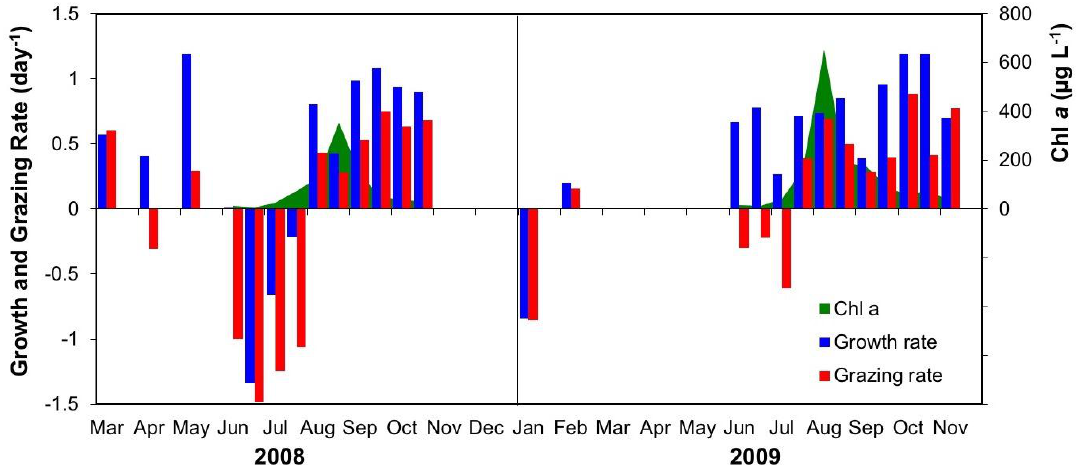
Figure 9. Intrinsic phytoplankton growth rates (blue) and microzooplankton grazing rates (red) determined from dilution experiments conducted in Vancouver Lake from March 2008 to November 2009. Green area represents mean chl a concentration measured on the date of each experiment. Data from [71] and G. Rollwagen-Bollens et al. (unpublished).